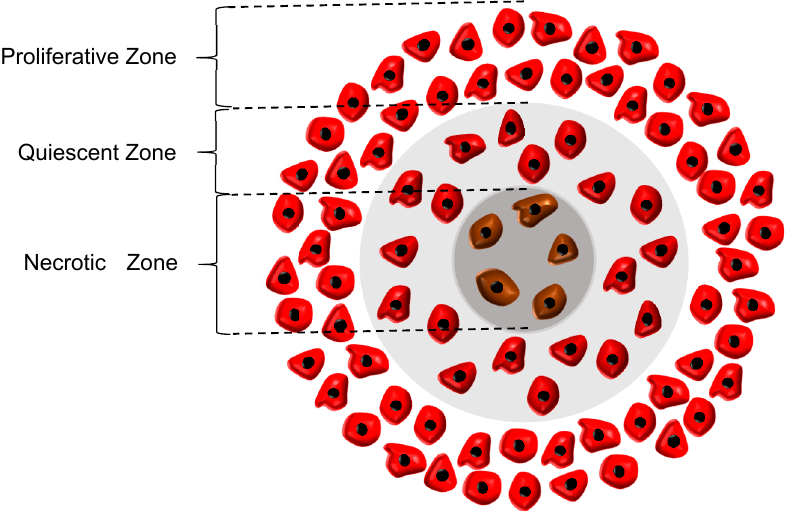
Figure 1. Three main regions in a tumor. Proliferative zone, nutrients concentrations are above their critical value; Quiescent zone, the concentration of one of the nutrients fall below its critical value; Necrotic zone, nutrients concentrations are below their critical value.